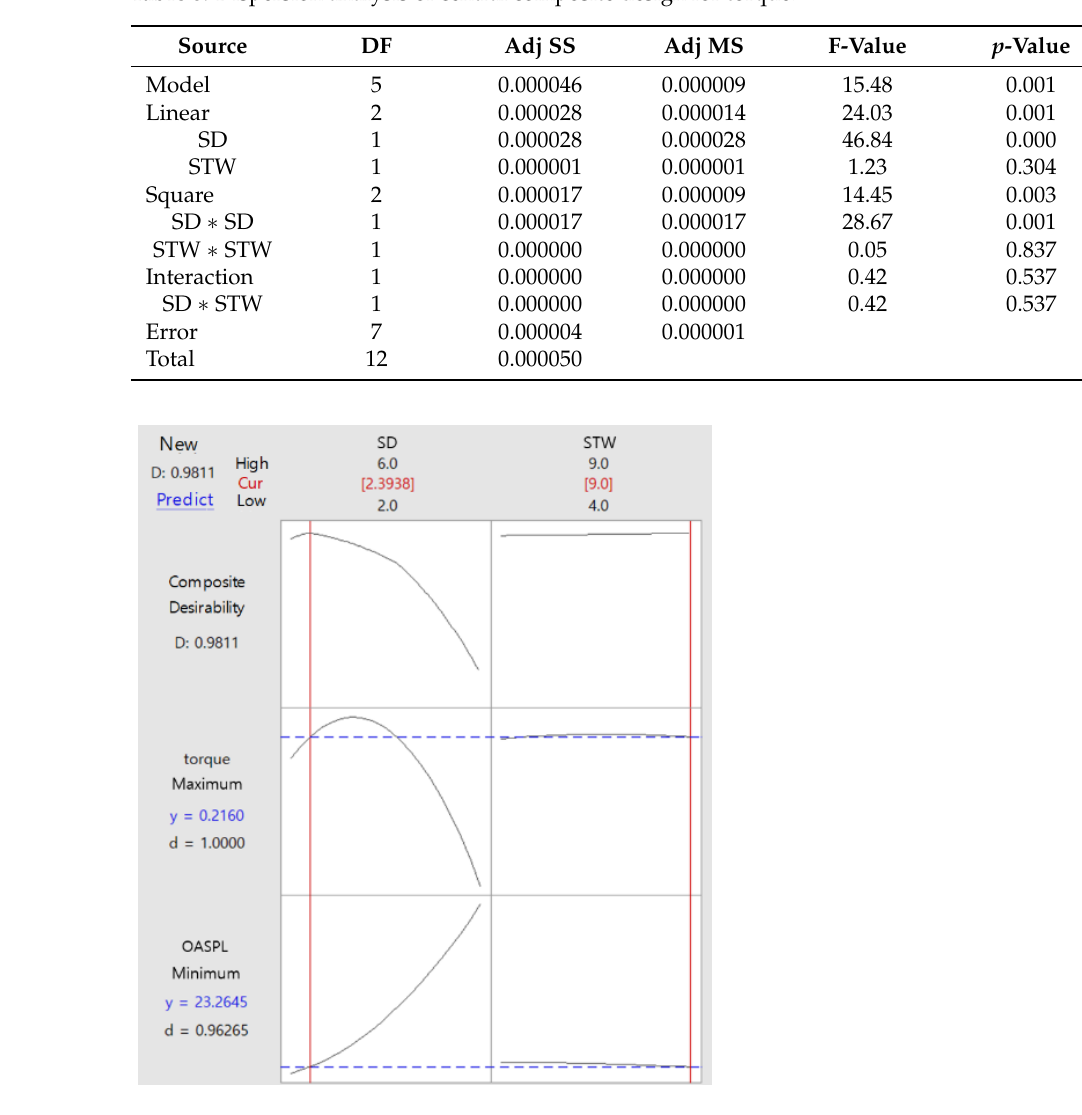
Table 8. Dispersion analysis of central composite design for torque.